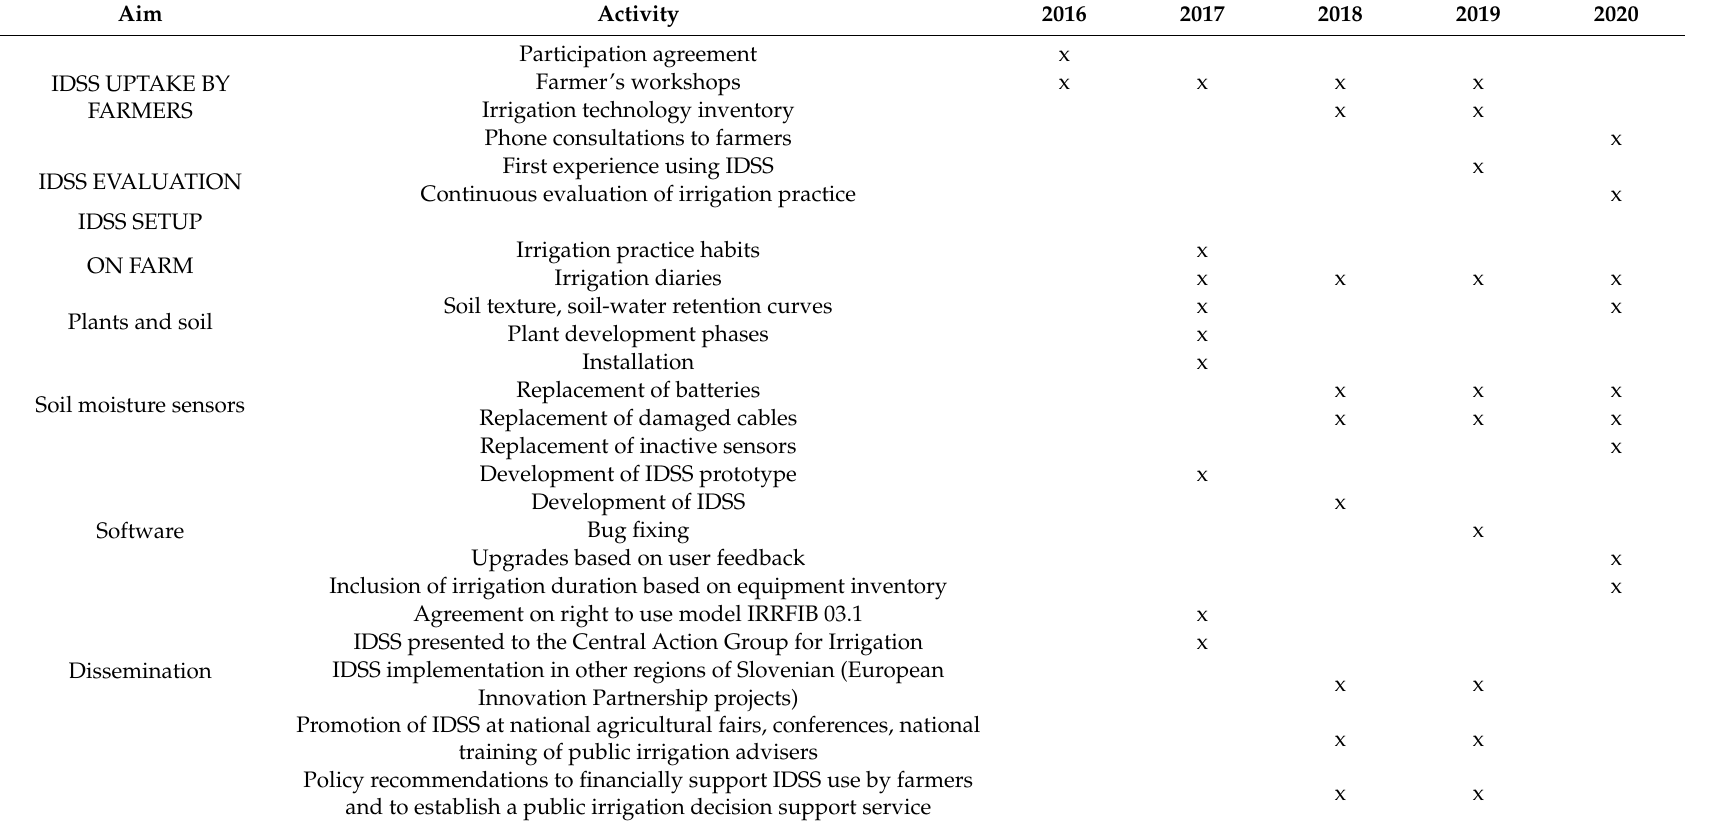
Table 1. Overview of activities for the introduction and uptake of irrigation decision support tool at the case study